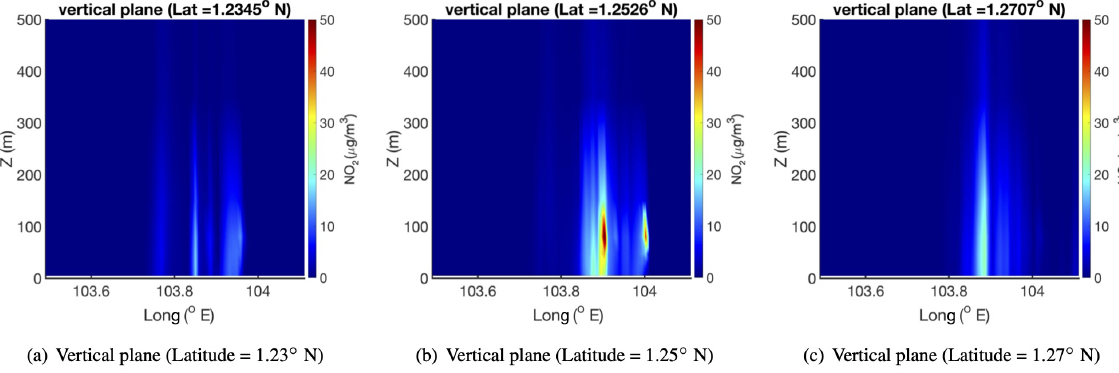
Figure 9. Vertical NO 2 profiles (west–east direction) at t = 60min.